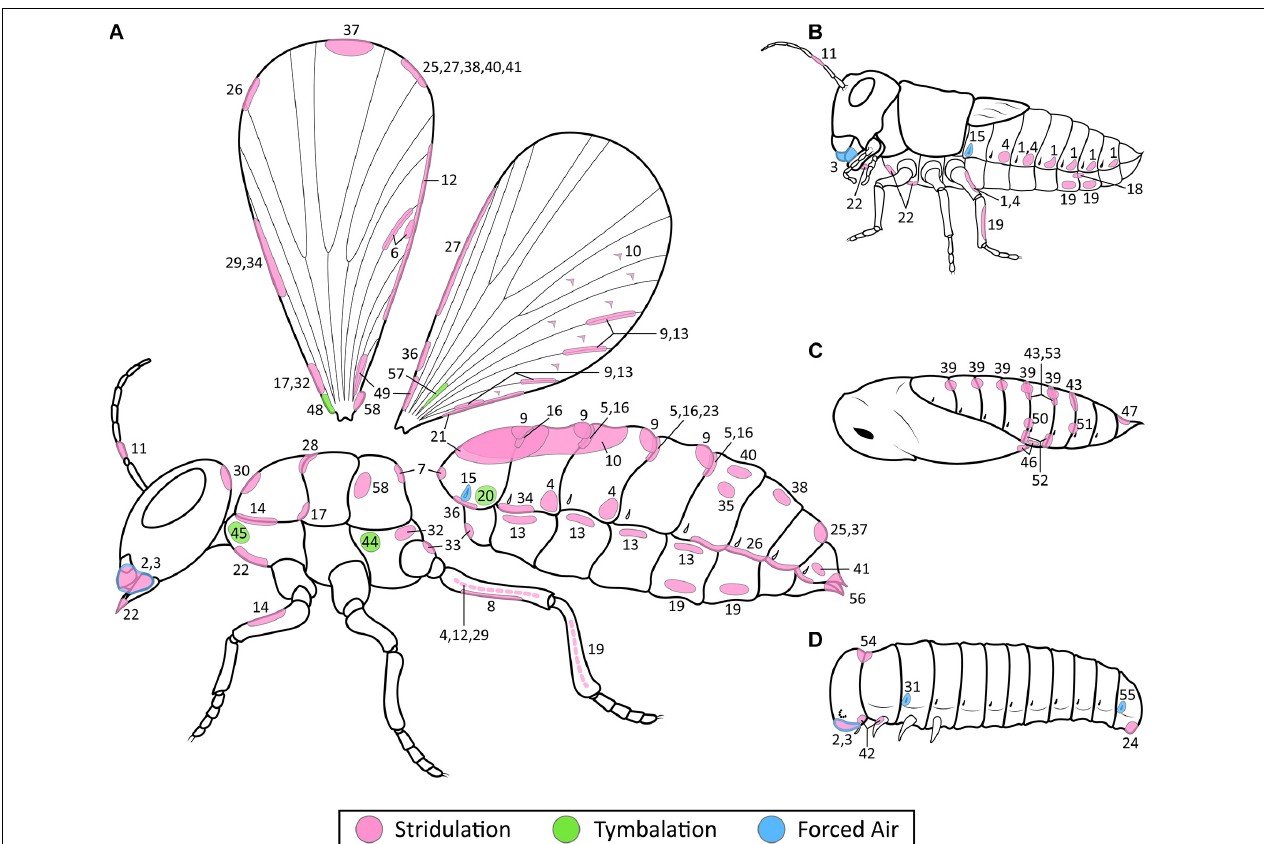
FIGURE 3 | Location of stridulation, tymbalation, and forced air mechanisms used for producing defense sounds in adult and juvenile insects. Percussion and tremulation were excluded as they generally employ undifferentiated body parts. Each number represents a position where a sound-producing mechanism has been recorded in the literature. (A) Generic adult insect. (B) Generic nymph. (C) Generic pupa. (D) Generic larva. The numbers correspond to their order of appearance in Table 1 , which includes information on the orders, families, and literature citations. Mechanisms by insect order are as follows: 1: Odonata. 2–3: Orthoptera and Lepidoptera. 4–10: Orthoptera. 11: Phasmatodea. 12–14: Mantodea. 15–18: Blattodea. 19–22: Hemiptera. 23–24: Hymenoptera. 25–41: Coleoptera. 42: Trichoptera. 43–57: Lepidoptera. 58: Mecoptera. Tymbal mechanisms (numbers 20, 44, 45, 48, and 57) are in green. Forced air mechanisms (numbers 3, 15, 31, and 55) are in blue. Stridulatory mechanisms (all other numbers) are in pink. In stridulatory mechanisms that involve two rubbing parts, both parts are given the same number. A dotted line represents a mechanism located on the inner surface of that appendage. Note that numbers 8 and 35 do not have a corresponding location marked on the wings as the entire wing is used in these